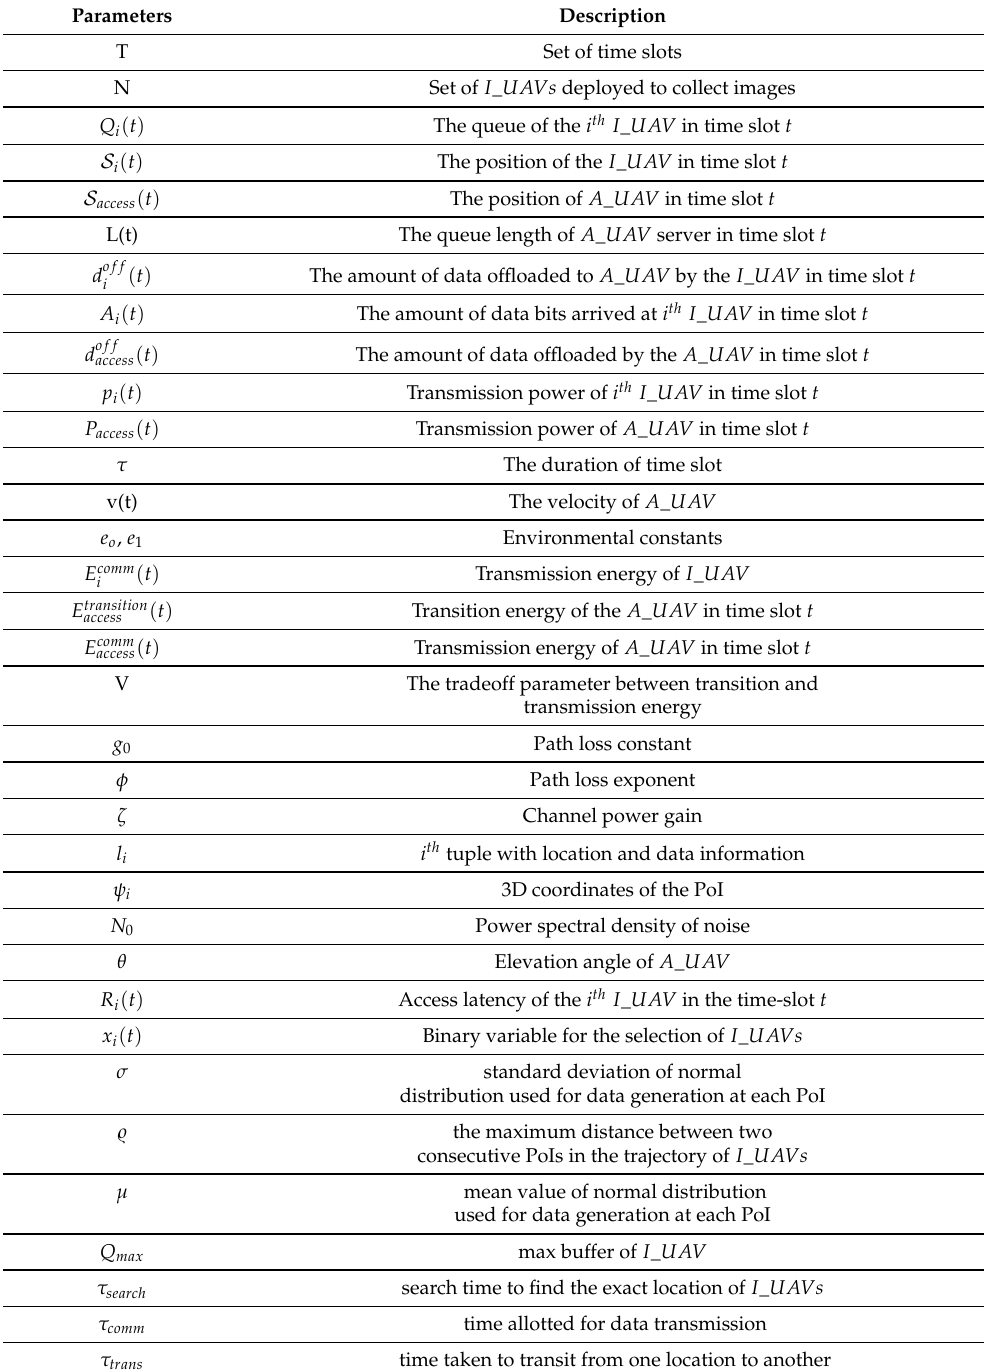
Table 1. List of